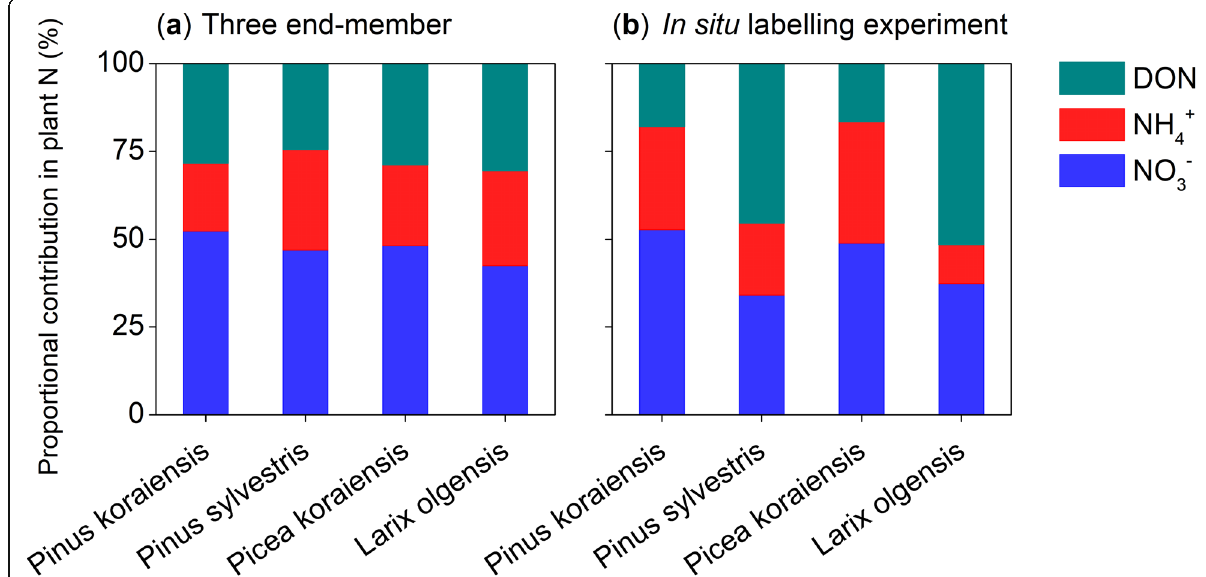
Fig. 5 Contribution of DON, NH 4+ , and NO 3 − to plant N uptake in the four forest plantations calculated by the three end-member ( a ), and calculated according to the results of in situ labelling experiment in the previous study ( b , Methods and Materials, Zhou et al.